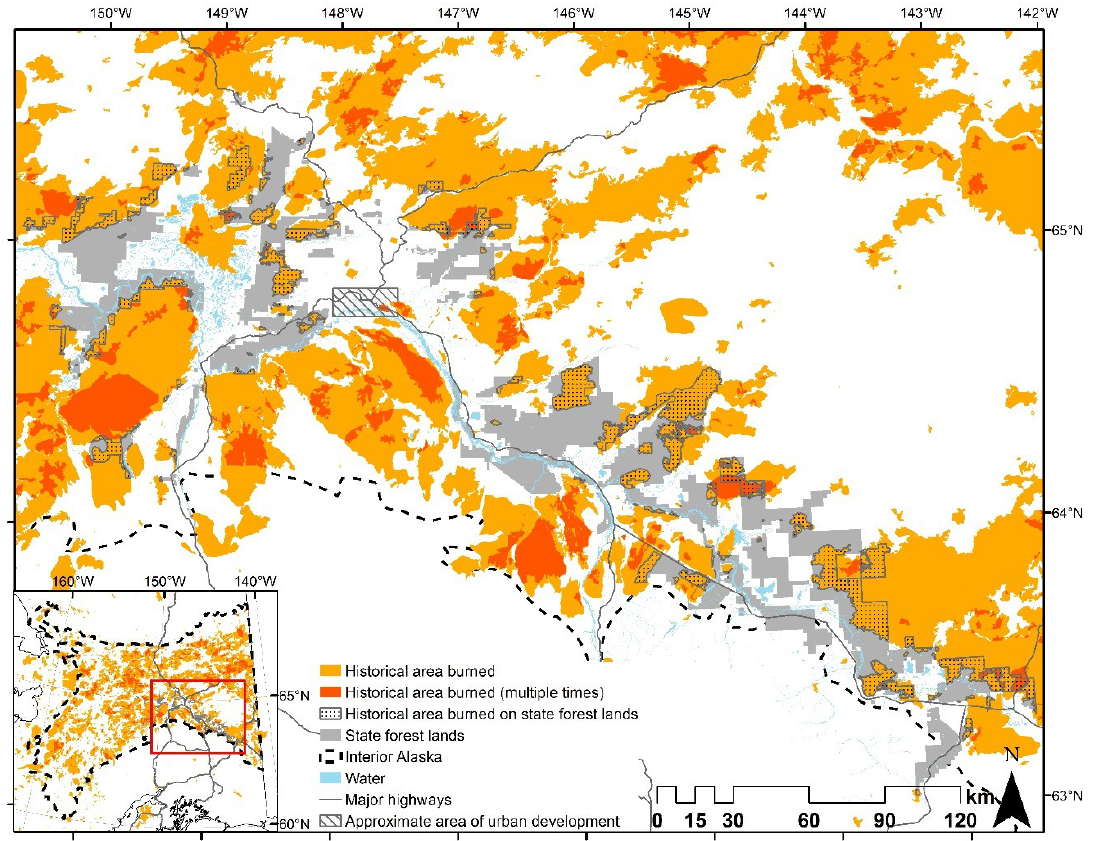
Figure 2. Historical wildfire perimeters between 1943 and 2017.